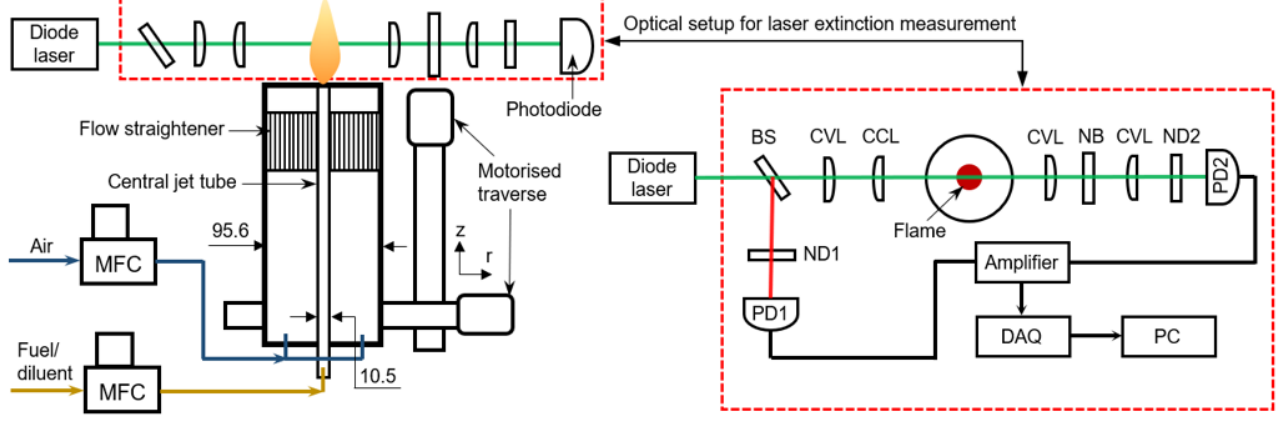
Figure 1. Schematic of the co-flow diffusion jet flame setup and the optical setup for laser extinction measurement. BS: beam splitter, ND: neutral density filter, PD: photodiode, CVL: convex lens, CCL: concave lens, NB: narrow band filter, AMP: amplifier, DAQ: data acquisition board. Dimensions are in